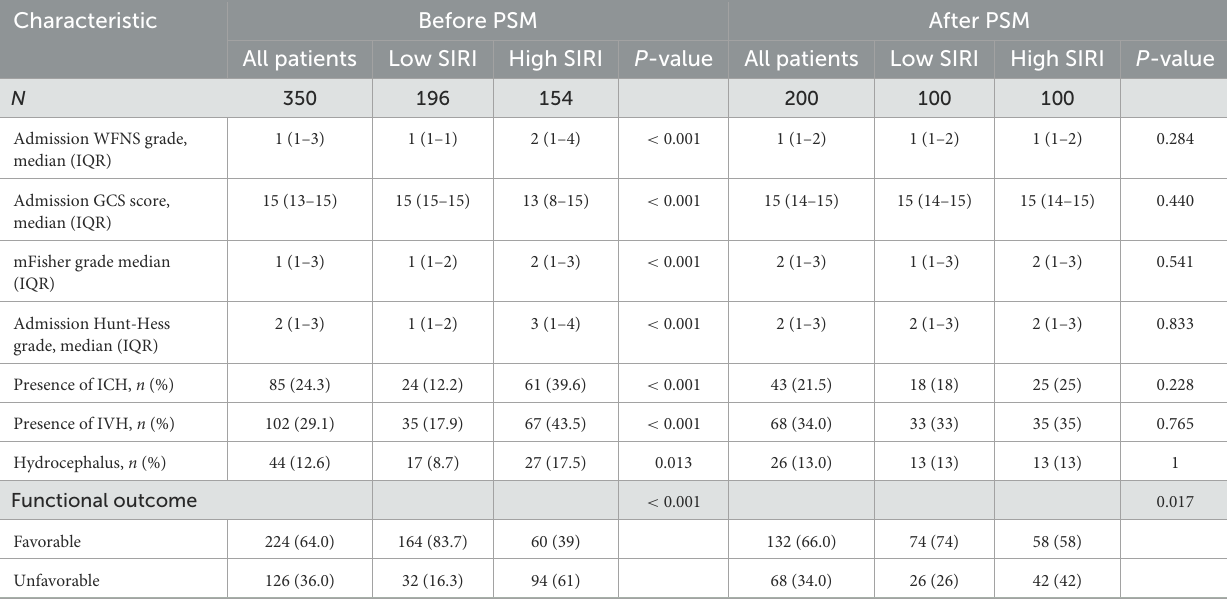
TABLE 3 Multivariate logistic regression analysis for functional outcome in aSAH patients before and after PSM. Characteristic Crude Model 1